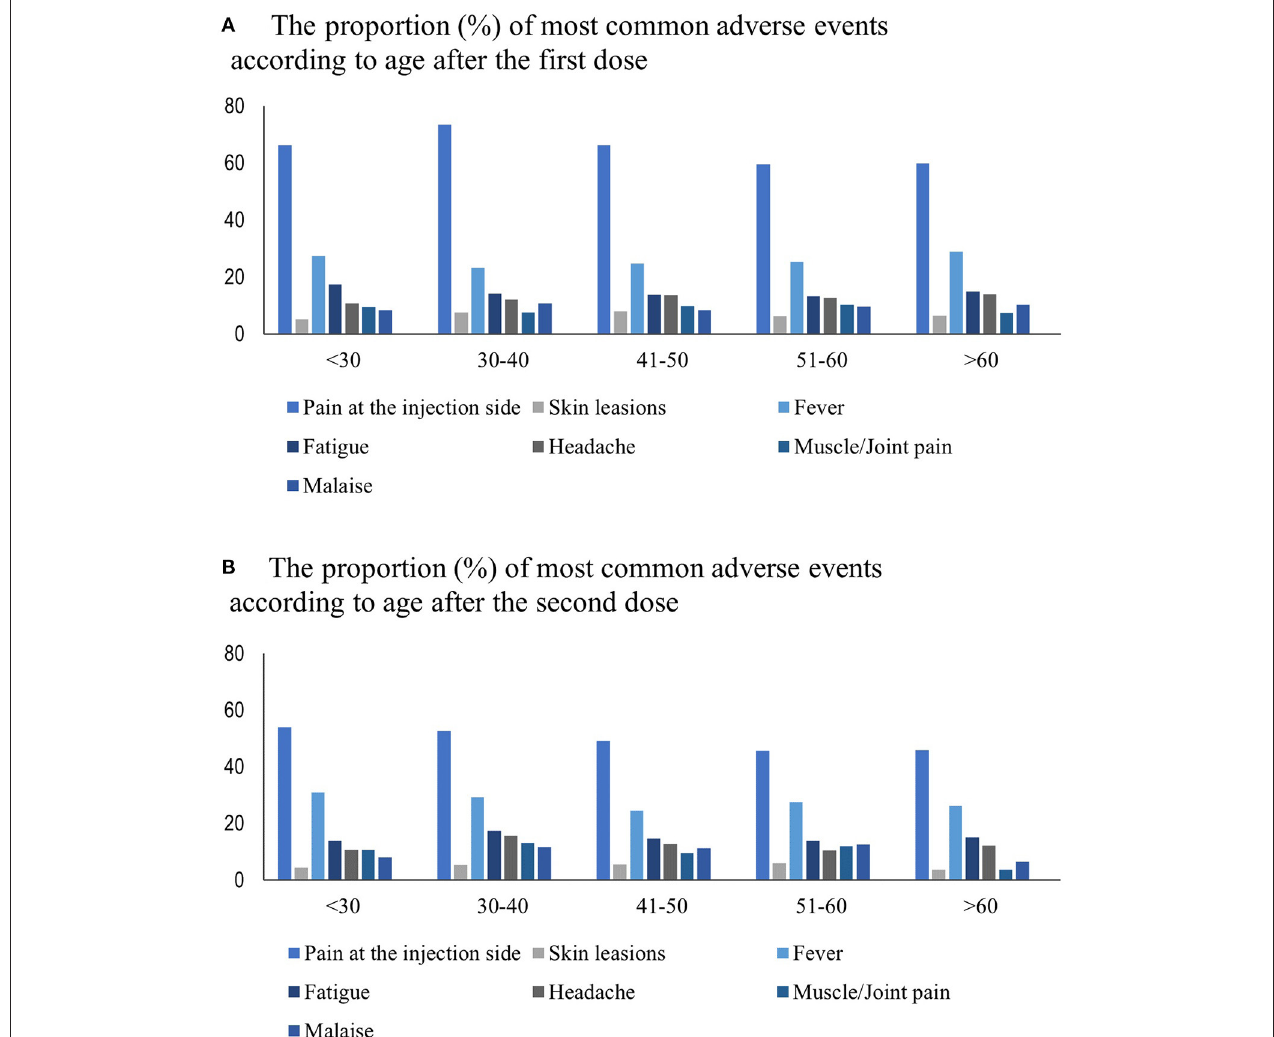
FIGURE 3 | (A) The proportion (%) of most common adverse events according to age after the first dose. (B) The proportion (%) of most common adverse events according to age after the second dose.